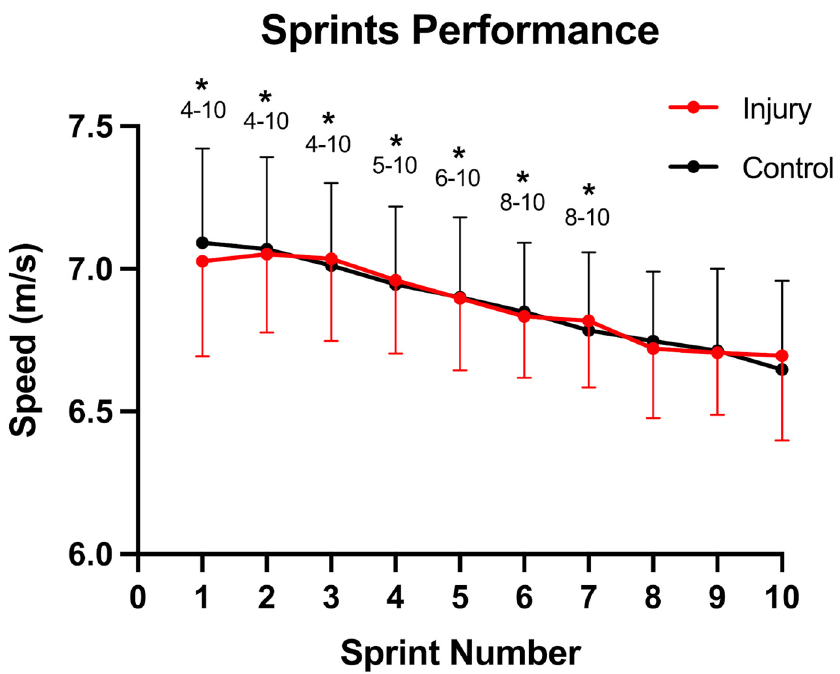
Figure 2. Average sprint speed values in the sprint performance of 10 sets × 30 m in players with no injury history (black) and players with injury history (red). Data are presented as mean ± standard deviation. * A significant difference between the current sprint and each subsequent sprint is indicated ( p < 0.05).